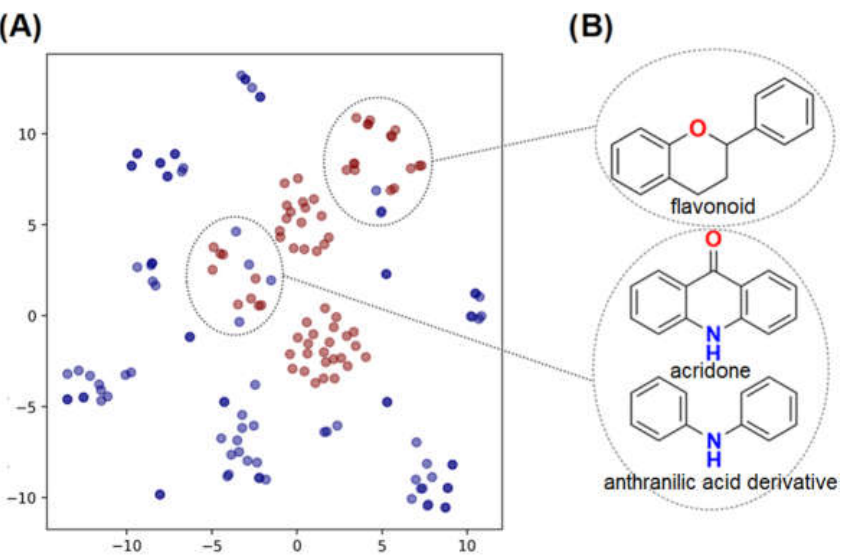
Figure 3. t-SNE plot showing the chemical space of known DENV RdRp inhibitors and our in-house database of natural and semi-synthetic compounds. ( A ) DENV RdRp inhibitors collected from the literature and PubChem are shown in blue circles. The in house natural and semi-synthetic database compounds are represented in red. ( B ) 2D structures of the main scaffolds found in each cluster.